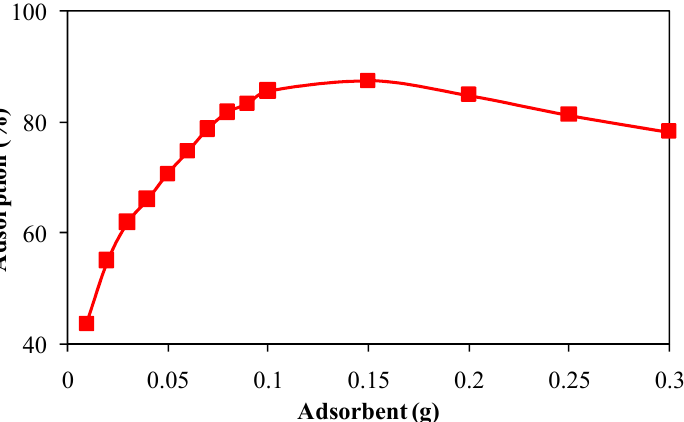
Figure 3. Effect of biosorbent dosage on the biosorption of RBV-5R using SCB at 20 µg/mL RBV-5R, pH set at 6, and 60 min of contact time with shaking.